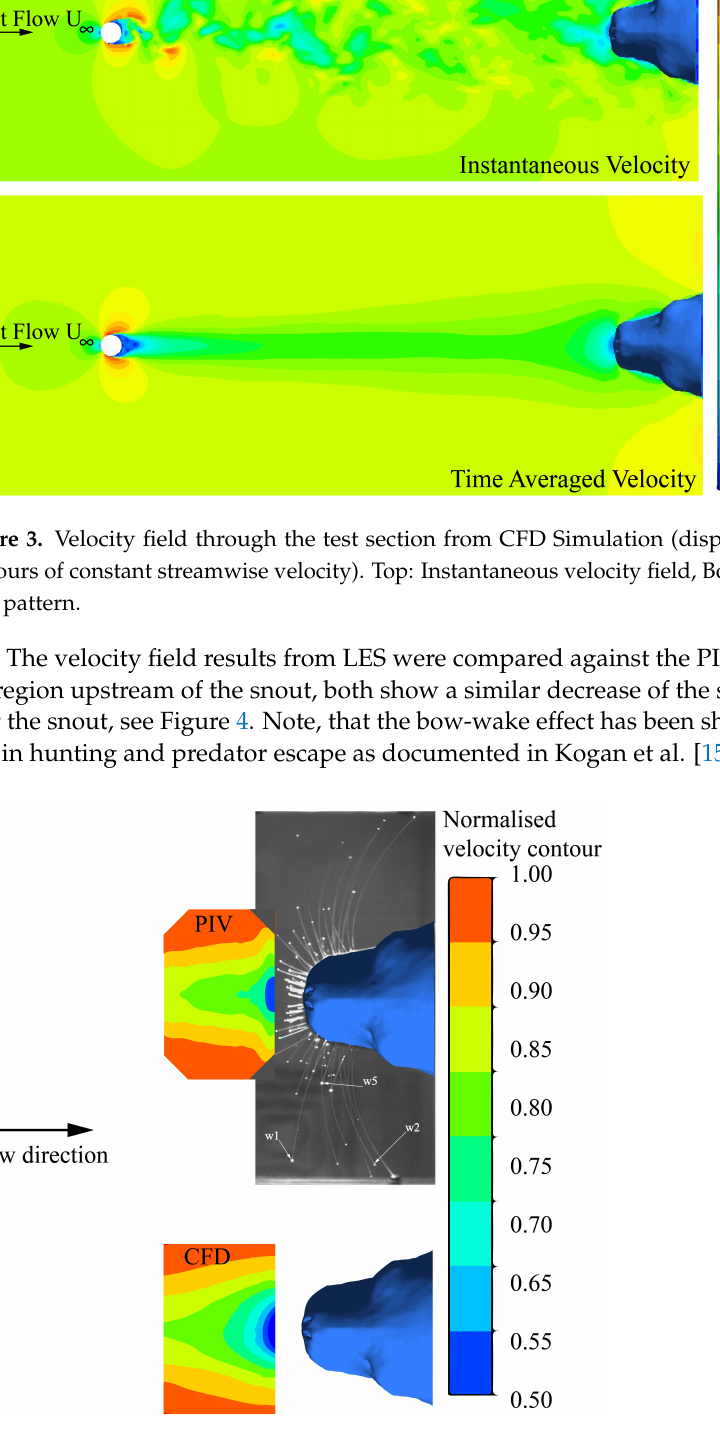
Figure 4. Bow-wake region in front of the snout from experimental flow field measurement using PIV compared to the CFD flow field (displayed as color-coded contours of constant streamwise